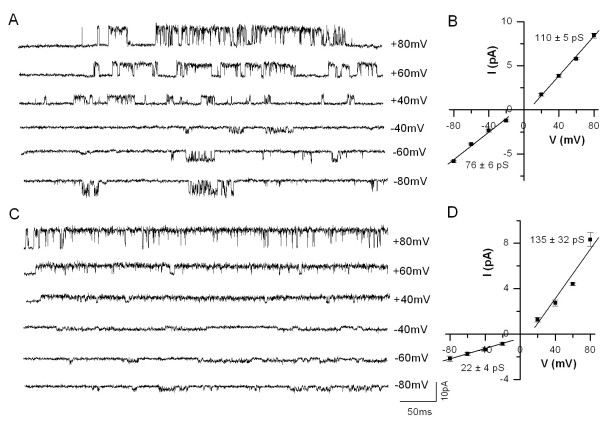
Current-voltage relationship of 4α-PDD-evoked single-channel current in TRPV4 transfected HEK 293T cells and in DRG neurons natively expressing TRPV4. A. Single-channel currents induced by 4α-PDD recorded at different membrane potentials from transfected HEK 293T cells. B. Current-voltage relationship shows that single-channel conductance is lower at negative potentials (76 ± 6 pS) as compared to positive potentials (110 ± 5 pS). C. Single-channel currents induced by 4α-PDD recorded at different membrane potentials from DRG neurons. D. Current-voltage relationship shows that the single-channel conductance is lower than that of cloned TRPV4 at negative potentials (22 ± 4 pS) as compared to positive potentials (135 ± 32 pS). The single-channel conductance contributes to the macroscopic current rectification.